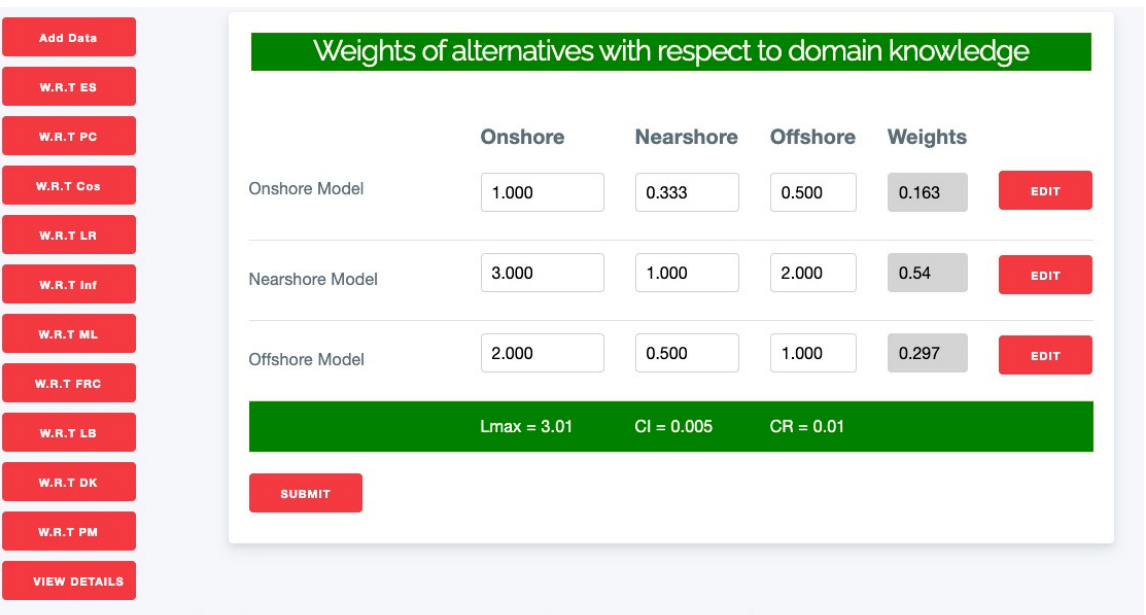
Figure A8. Alternatives weights with reference to DM and CR.